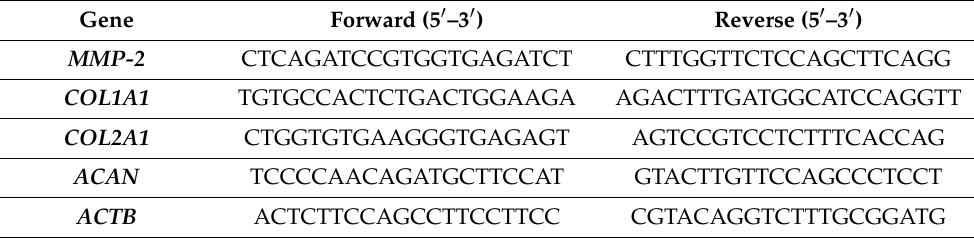
Table 1. Primers used for